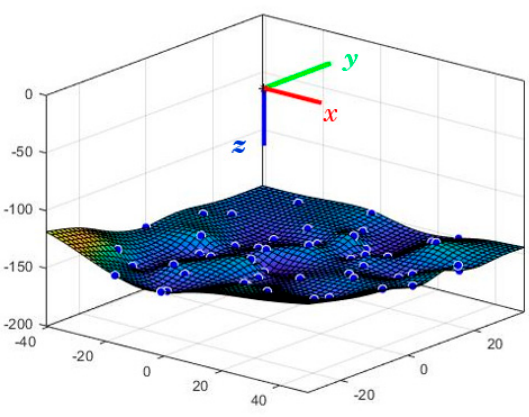
Figure 10. End effector positions. Source: